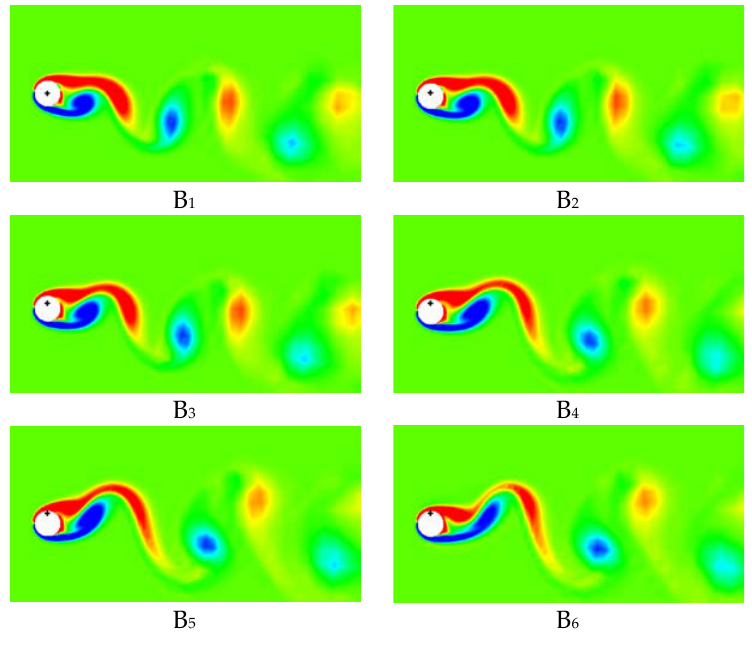
B . When the symmetric 5 650 t = , the cylinder vibration and the fluid 2 ~ B B ) while the wake vortex is inclined to the lower 6 8